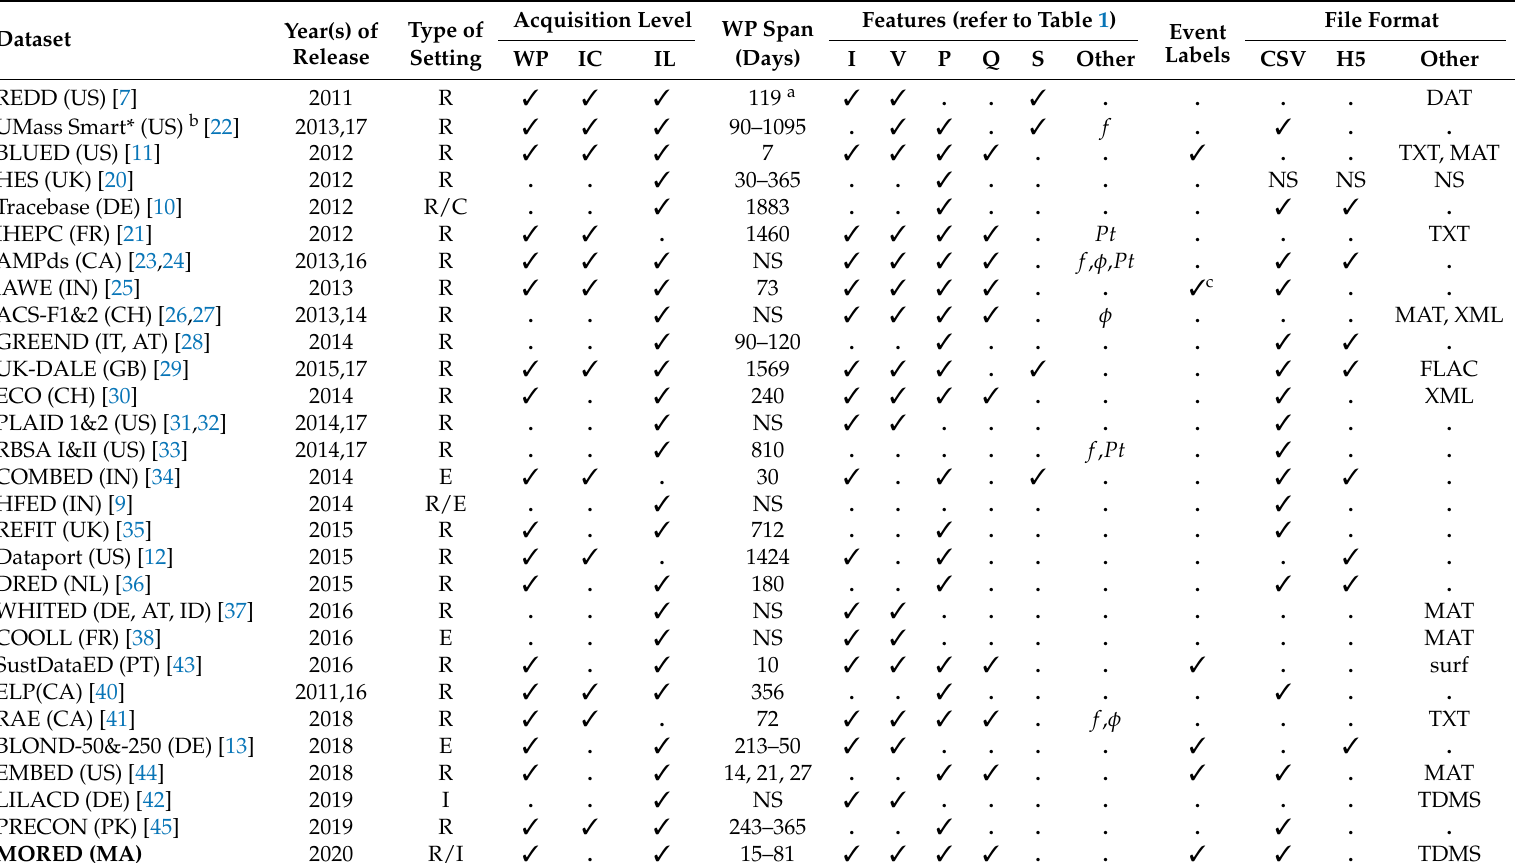
Table 2. Summary of all open datasets specific to electricity disaggregation; (R: residential, C: commercial, E: educational, I: industrial, NS: not